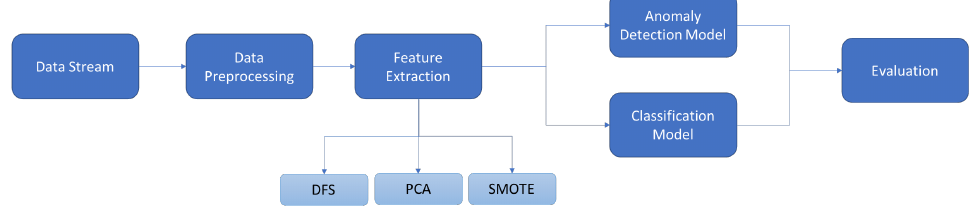
Figure 1. Research